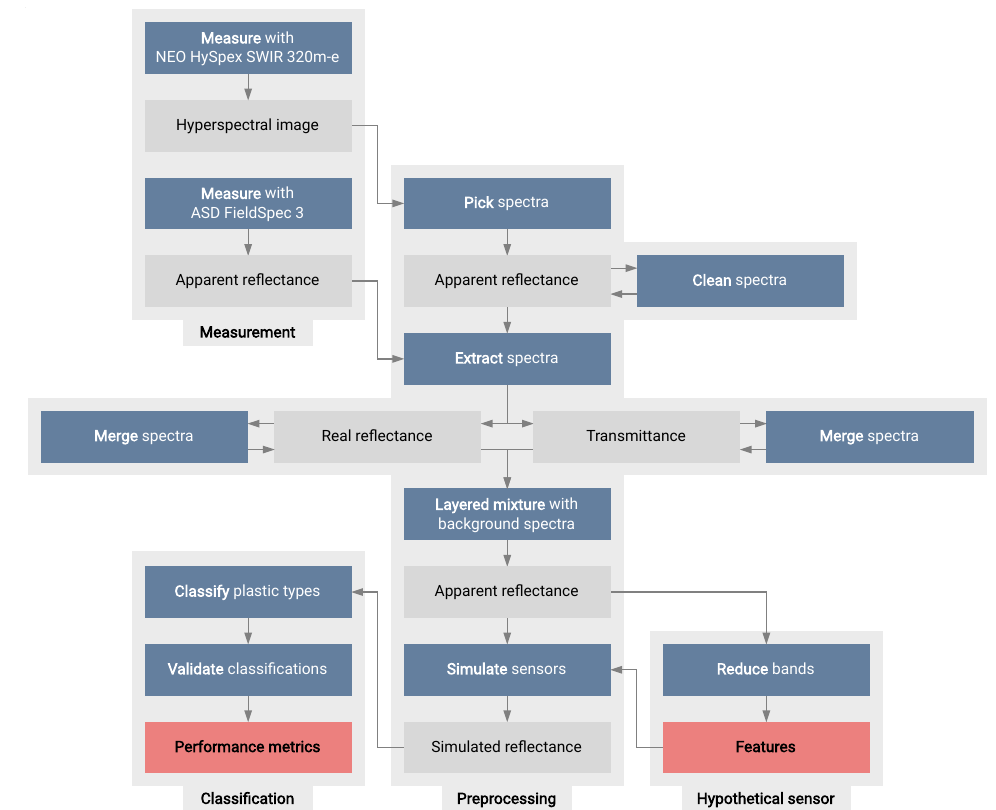
Figure 3. Data processing workflow as in the course of this study. Blue are work steps, gray are data, and red are major